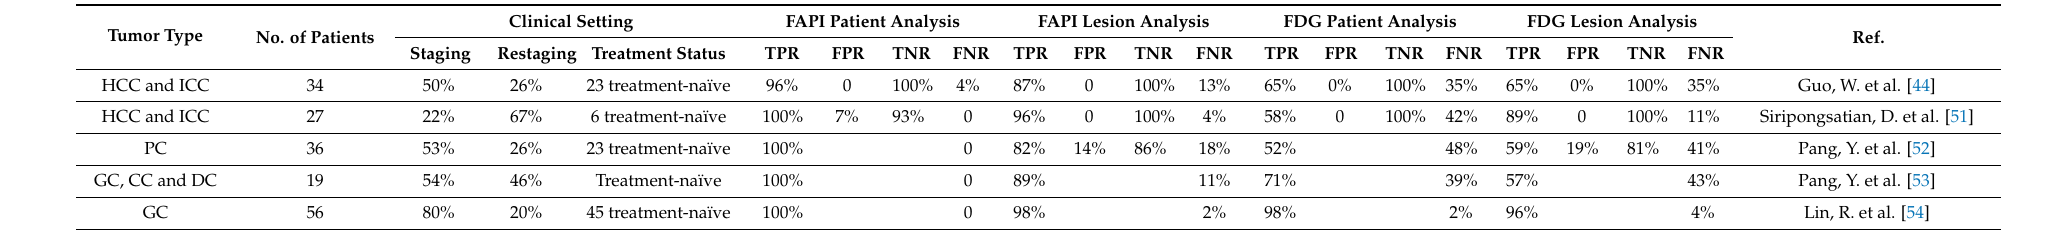
Table 1. Comparison of FAPI PET/CT and FDG PET/CT in the imaging of hepatobiliary and gastrointestinal carcinomas. HCC: hepatocellular carcinoma;